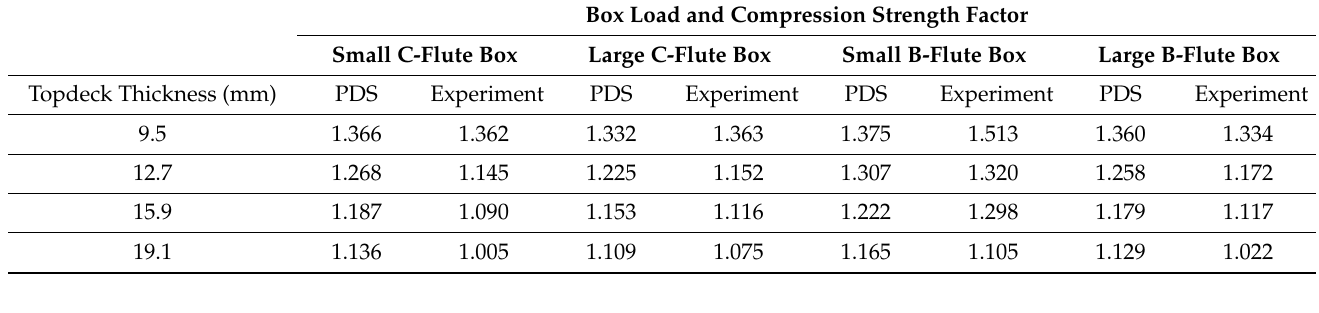
Table 3. Summary table of box load and compression strength factors.